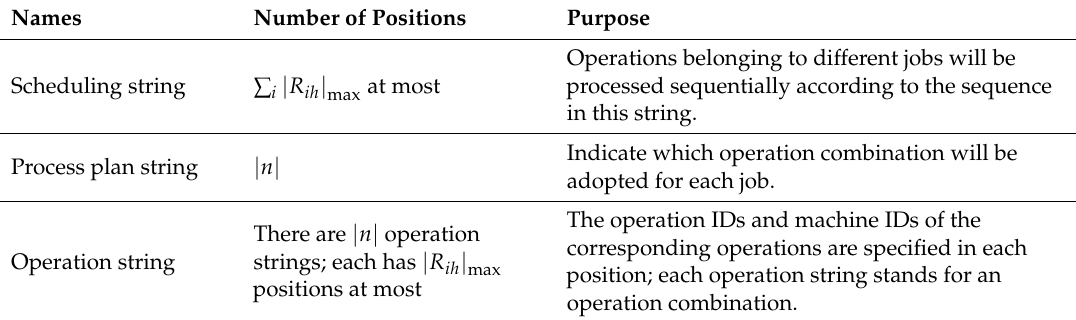
Table 1. Description of three